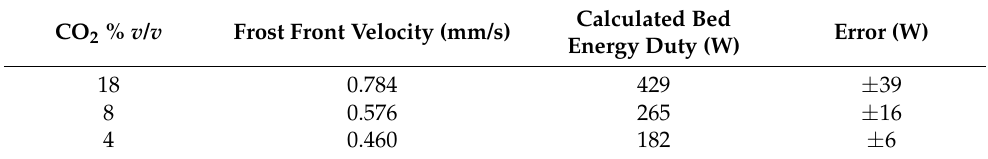
Table 4. Calculated energy duties from experimental results